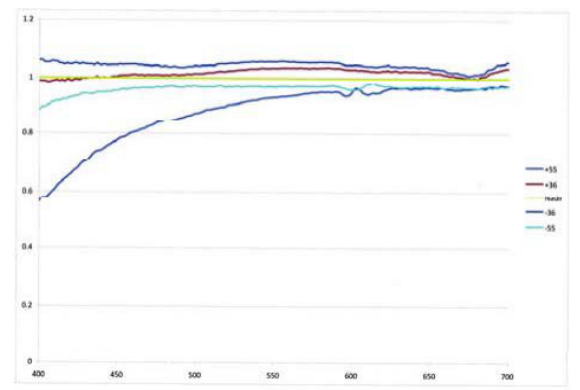
Figure 7: Normalized bidirectional reflectance factor for benthic microalgae in the solar principal plane for five view angles. adjoining Heron Island show that their reflectance is not Lambertian and that the bidirectional reflectance and normalized bidirectional reflectance factor may be sufficiently different to be used as a means of discriminating and classifying coral and other reef